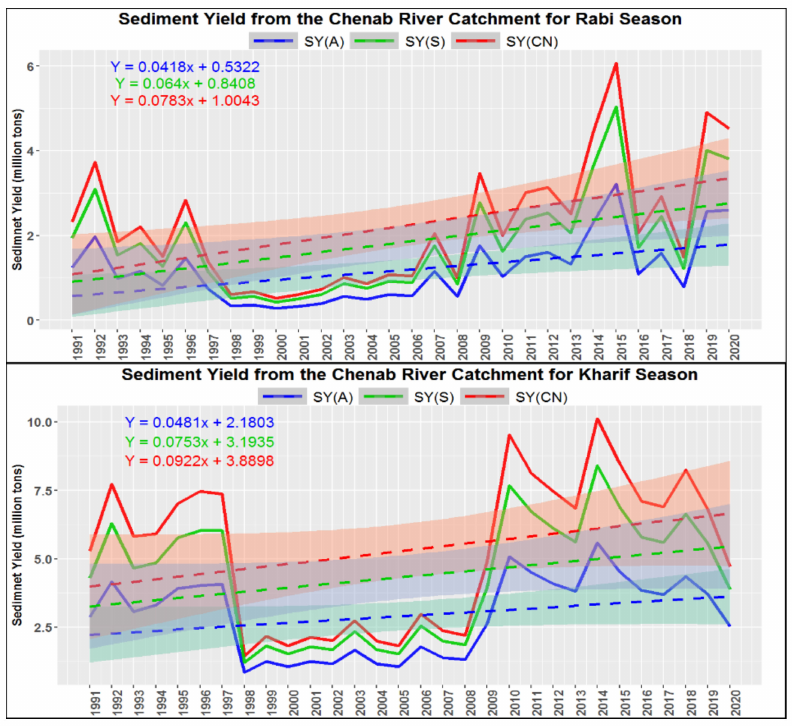
Figure 12. Sediment yield from the Chenab river catchment for rabi and kharif seasons